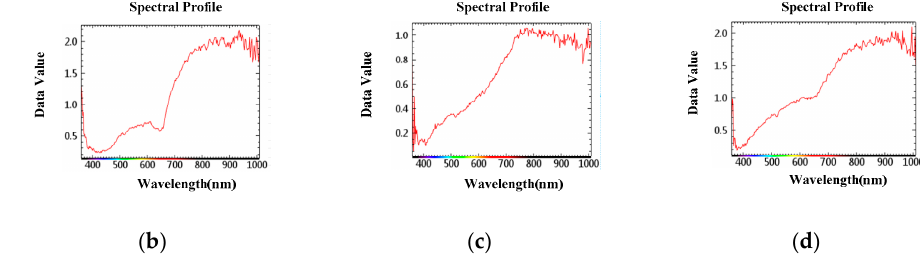
Figure 4. Spectral data of soybean gnawed by insects in different periods (( a ). Normal soybean; ( b ). Soybean with egg; ( c ). Soybean with larvae; ( d ). Gnawed soybean.).